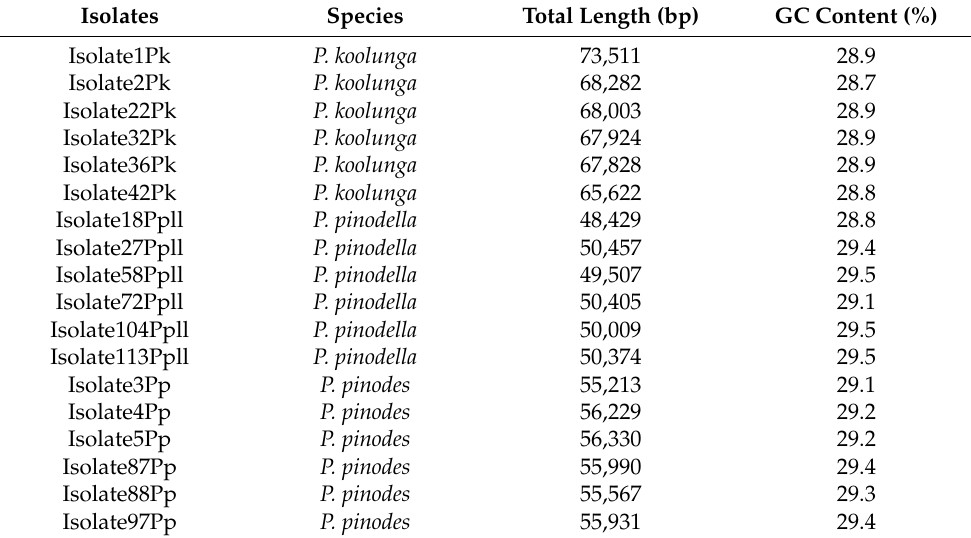
Table 6. Mitochondrial genome assembly statistics for AB